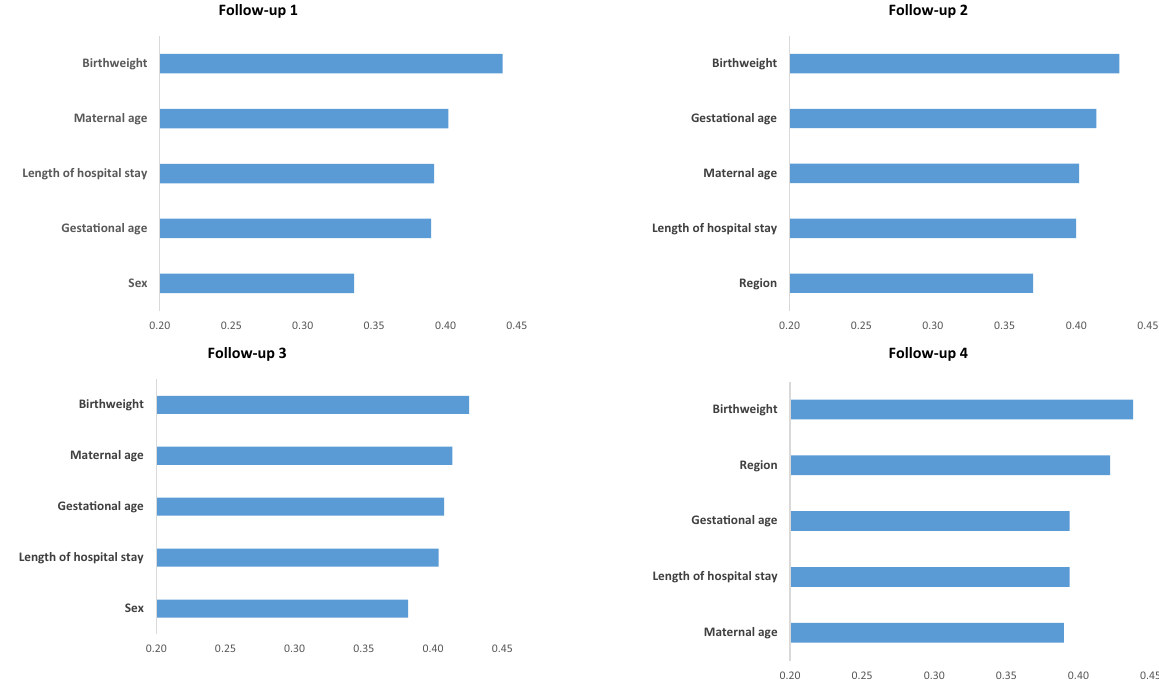
Figure 2. Importance of the predictor variables (based on the mean decrease in impurity) in the Random Forest for each year (Baseline